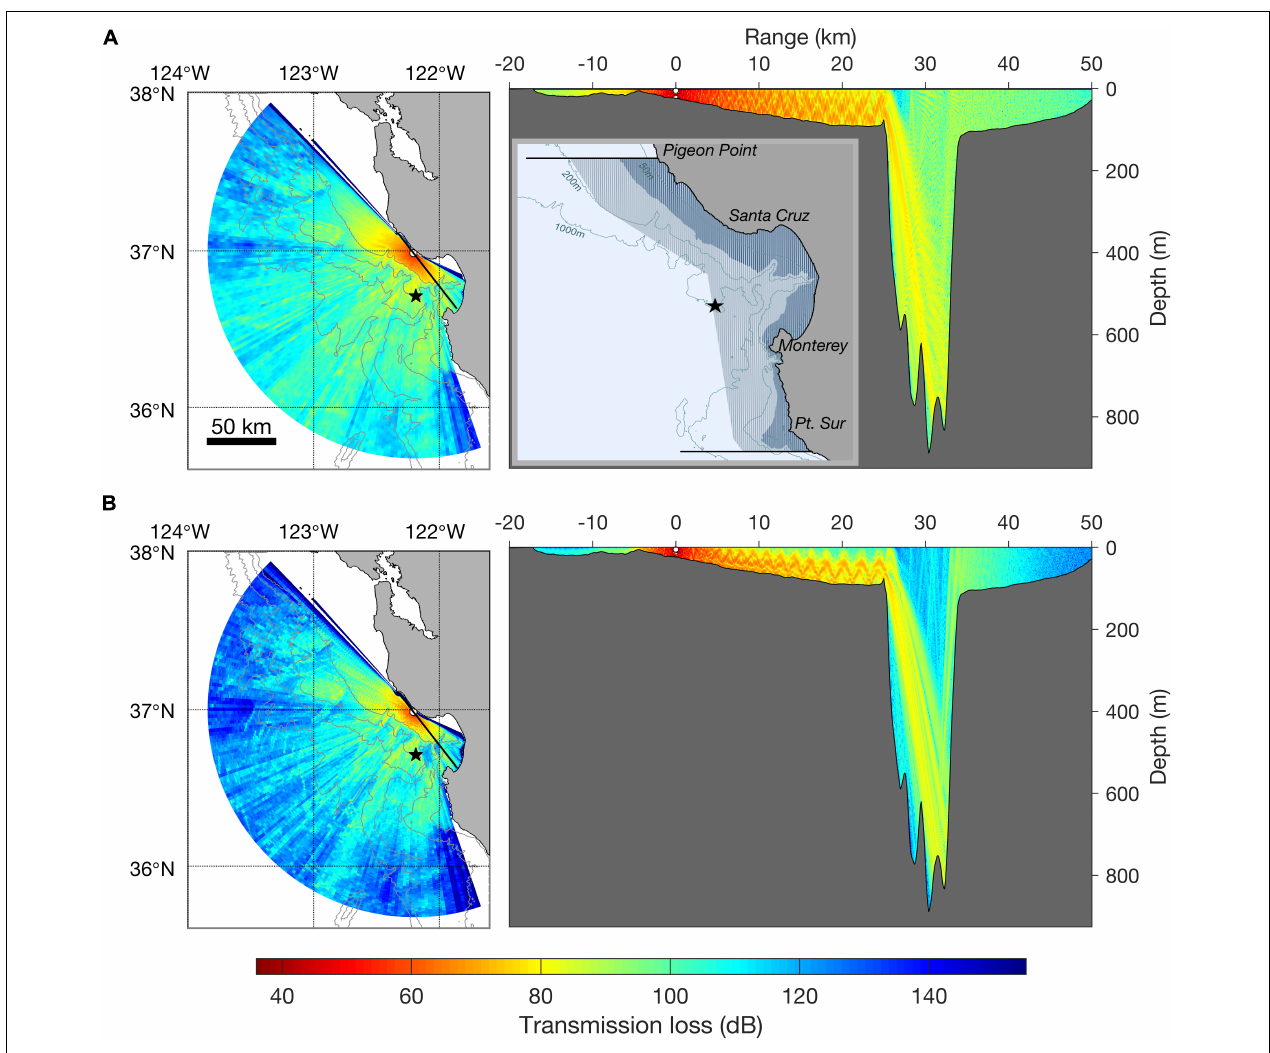
FIGURE 1 | Transmission loss model at 250 Hz (A) and 1000 Hz (B) for a seal bomb explosion (3 m depth, 36 ◦ 59 (cid:48) 6.20 (cid:48)(cid:48) N, 122 ◦ 11 (cid:48) 44.53 (cid:48)(cid:48) W, average August sound speed profile). Isobaths are 200, 1000, 2000, and 3000 m. Color indicates transmission loss at 20 m depth (left) and at all depths (right). Black star shows position of Monterey Accelerated Research System (MARS) cabled observatory (891 m), active since 2015, and where seal bombs have been acoustically detected. The right vertical profile shows the transmission loss model along a transect line (bearing 322 ◦ and 142 ◦ from the source; transect is shown by black thick line in horizontal range map). The inset map (top right) shows the distribution of the Monterey Bay harbor porpoise stock (black horizontal lines show recognized stock boundaries). Darker blue shading is primary habitat [ < 50 fathoms = 92 m] and medium blue shading shows the offshore extent of stock range. Isobaths in range map are 50, 200, and 1000